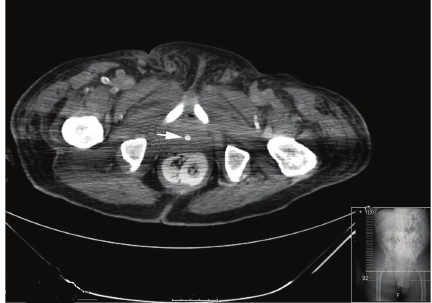
Figure 2: Patient 2: CT showing (arrow) the urethral catheter lodged in the prostatic urethra inducing obstruction to urinary